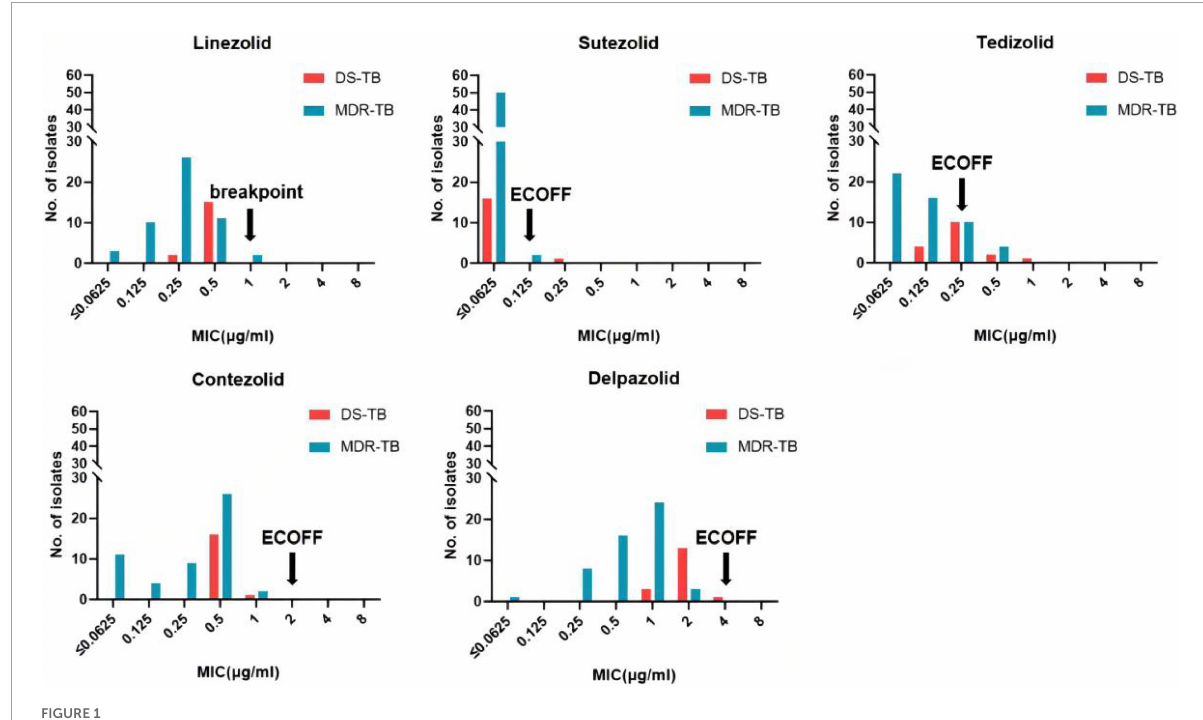
FIGURE1 MIC distributions of the five oxazolidinones against 69 Mtb clinical isolates.